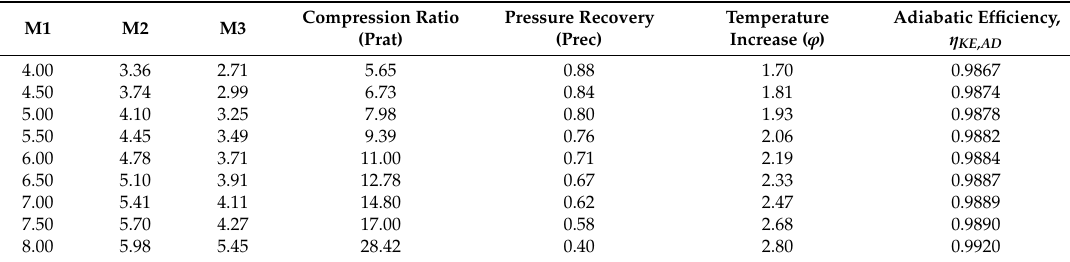
Table 2. Theoretical calculations for two ramp inlet.